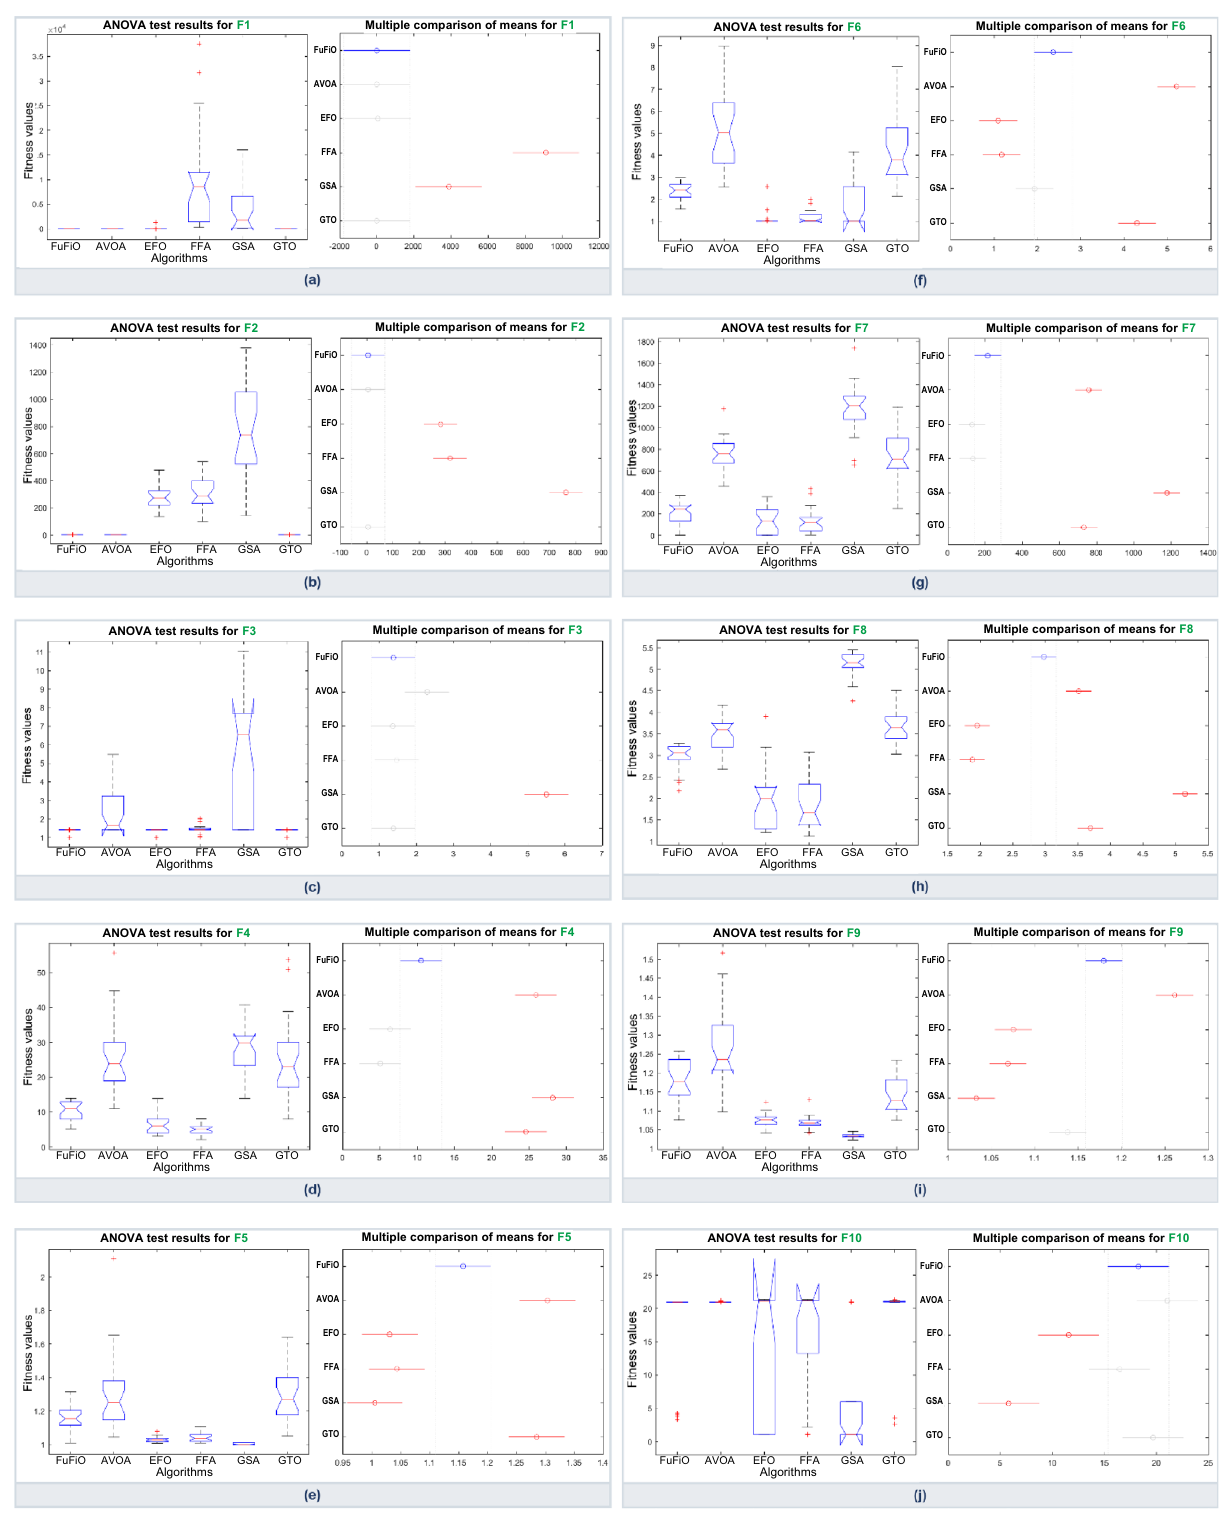
Figure 16. ANOVA test results for the CEC-2019